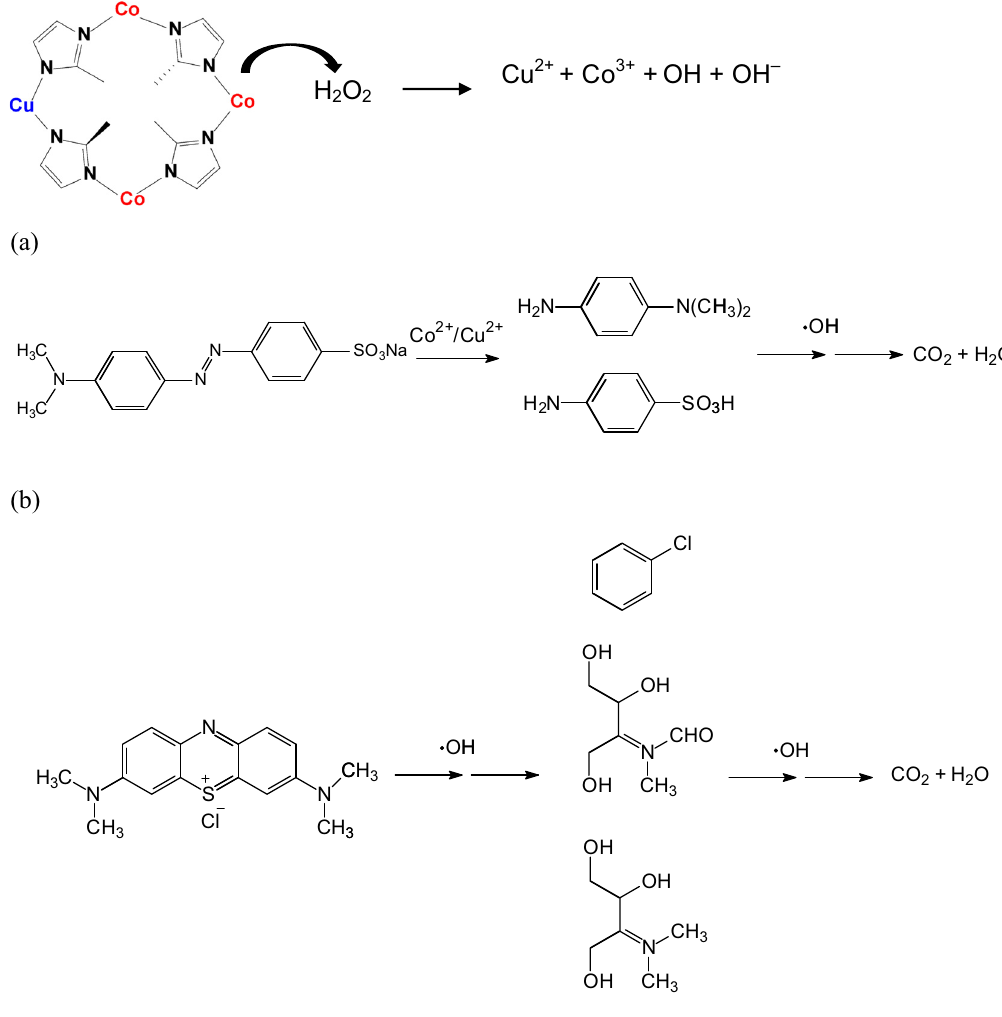
Figure 7: Summary of removal mechanism of ( a ) MO [ 38 ] and ( b ) MB [ 39 ]